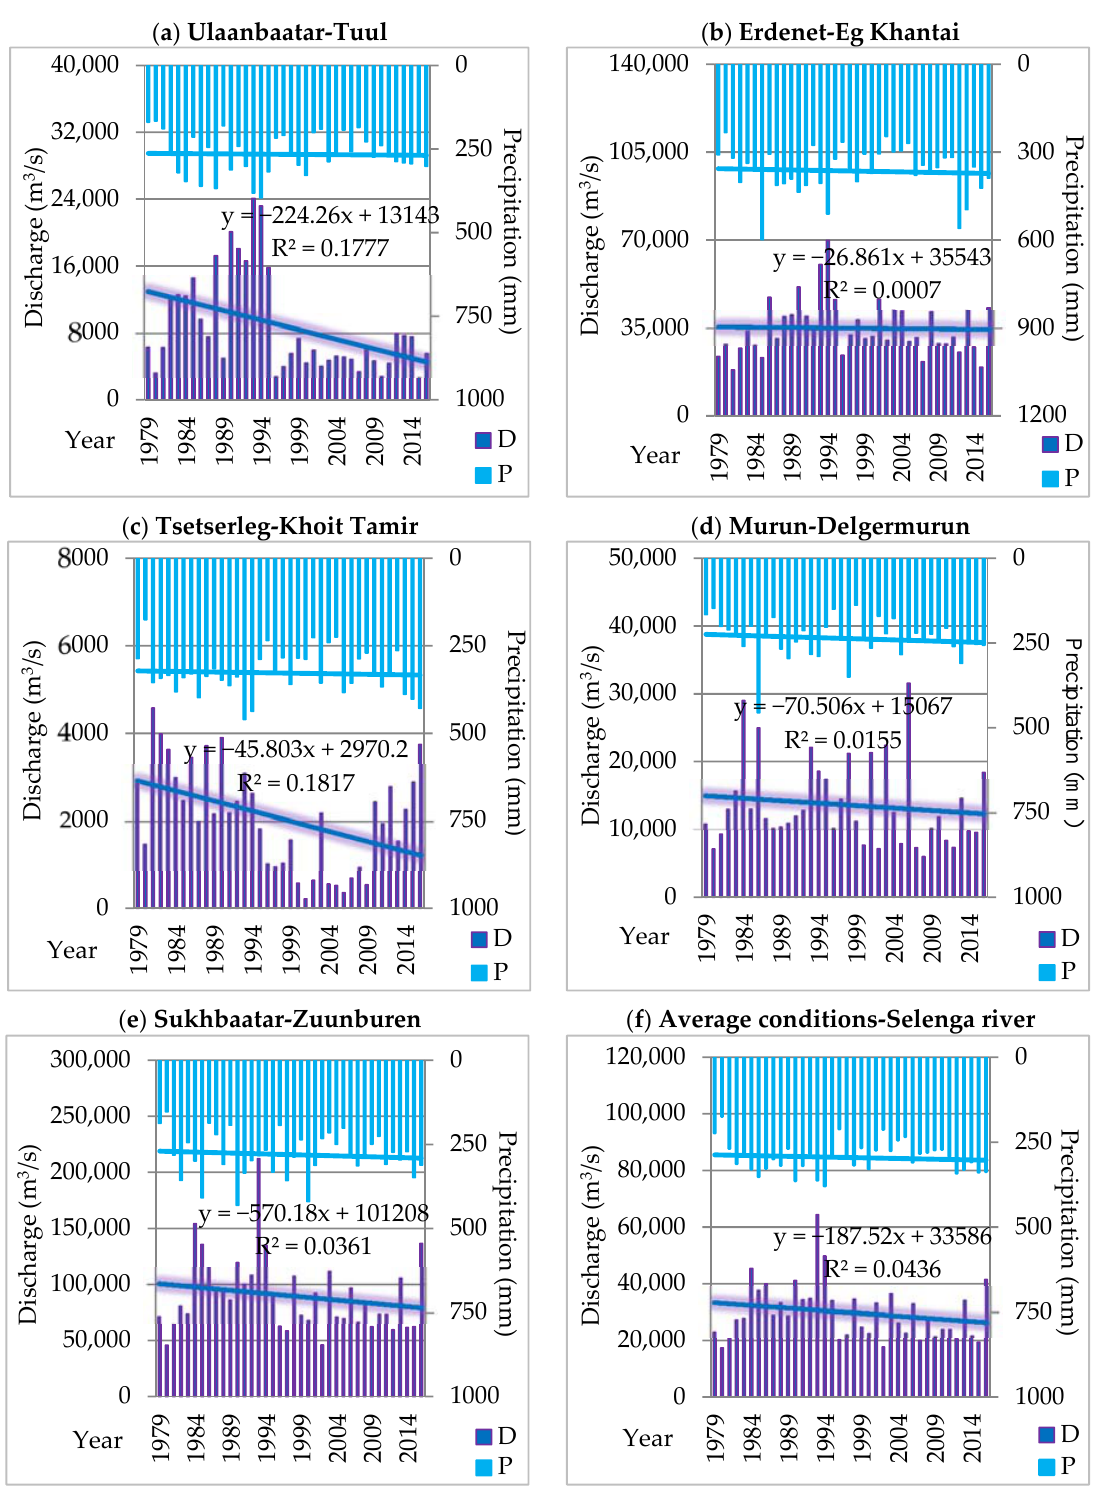
Figure 7. Long-term in precipitation and discharge change, in during 1979–2016.